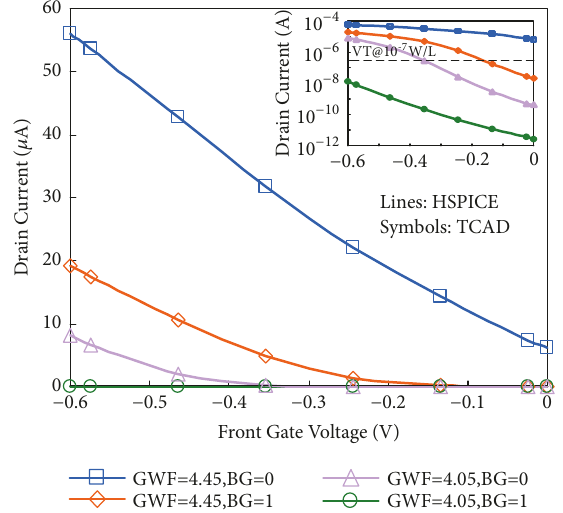
Figure 6: The currentcharacteristicresults of P-type DT IG FinFET from Sentaurus Device and